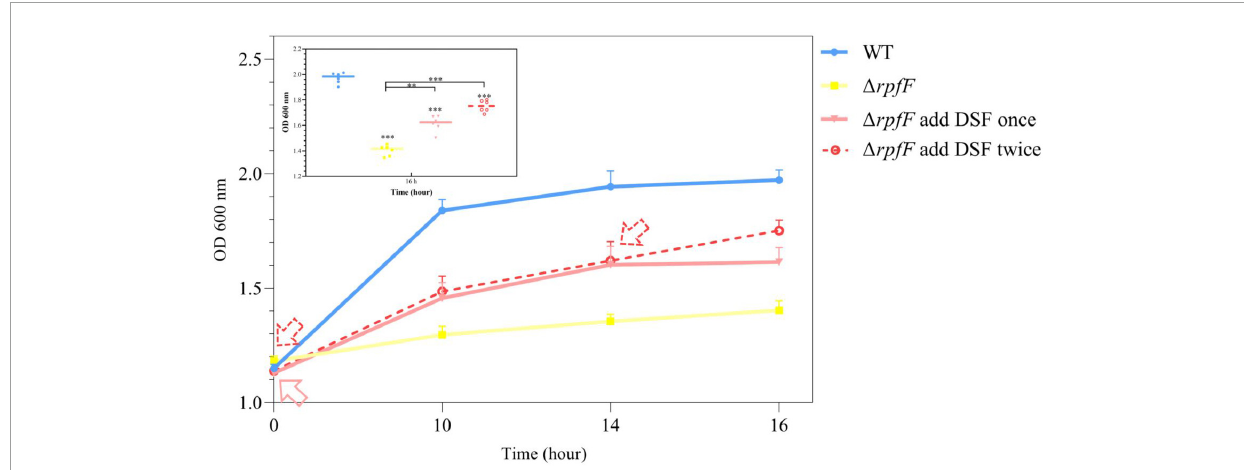
FIGURE3 Effect of supplementation of DSF on the growth of (cid:49) rpfF . The solid red arrow is the time point of a single addition of DSF; the red dashed arrow is the time point of two additions of DSF. The asterisks not marked with contrast lines represents a significant difference between each group and the group WT. Error bars indicate ± SD, n = 3. ANOVA, Tukey’s HSD test ( ∗∗ P < 0.01, ∗∗∗ P < 0.001).